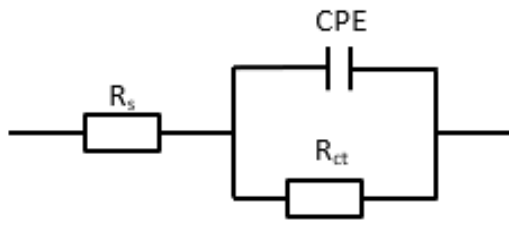
Figure 5. Equivalent circuit model. Table 2. Electrochemical impedance spectroscopy fitting date.